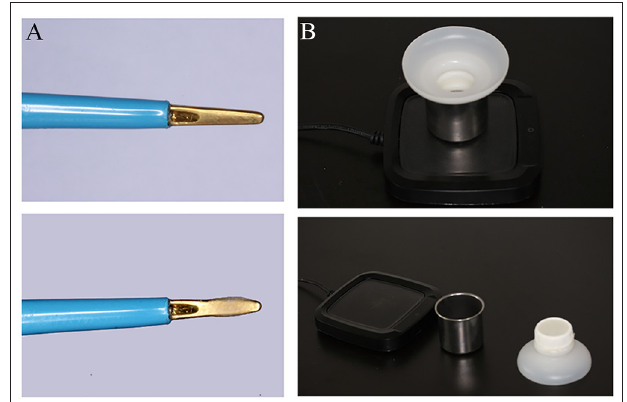
FIGURE 1 | Photograph depicting bone wax (BW) coated, uncoated bipolar forceps (A) and BW applied device (B) .